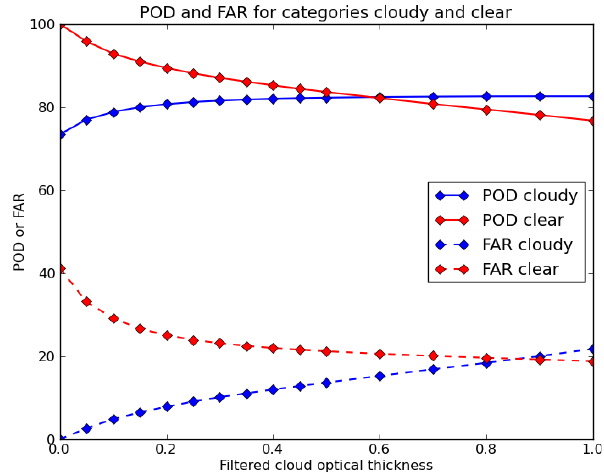
Fig. 7. Same as Fig. 4 but after treating CLARA-A1/PPS misclassi- fied clear pixels as truly clear and not as cloudy (see motivation in text).